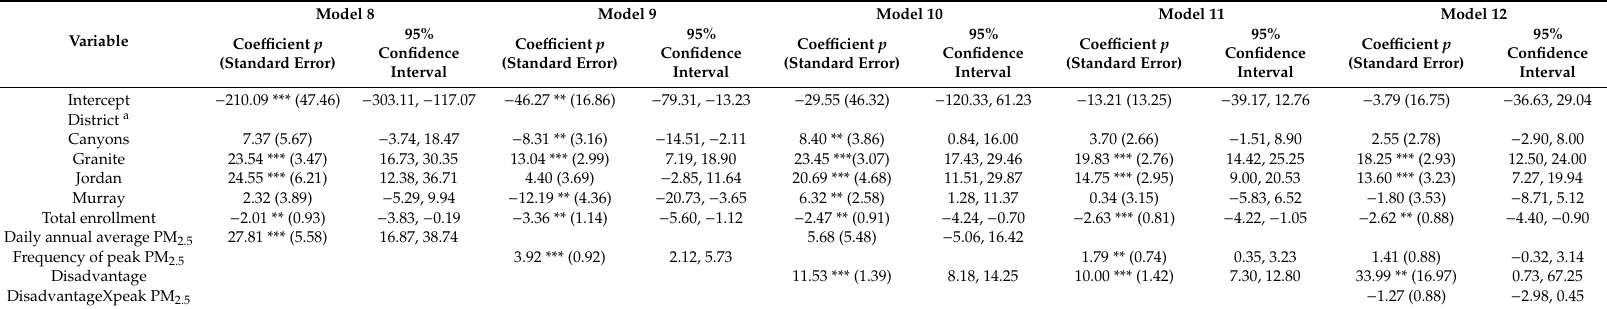
Table 4. Results of the Generalized Estimating Equations (GEEs) predicting the percentage of students below proficient in English language arts (ELA) at Salt Lake County public primary schools ( n =